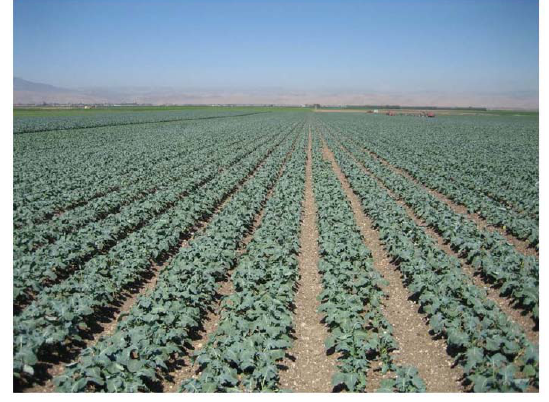
Fig. 2 . Organic broccoli production as a monoculture in